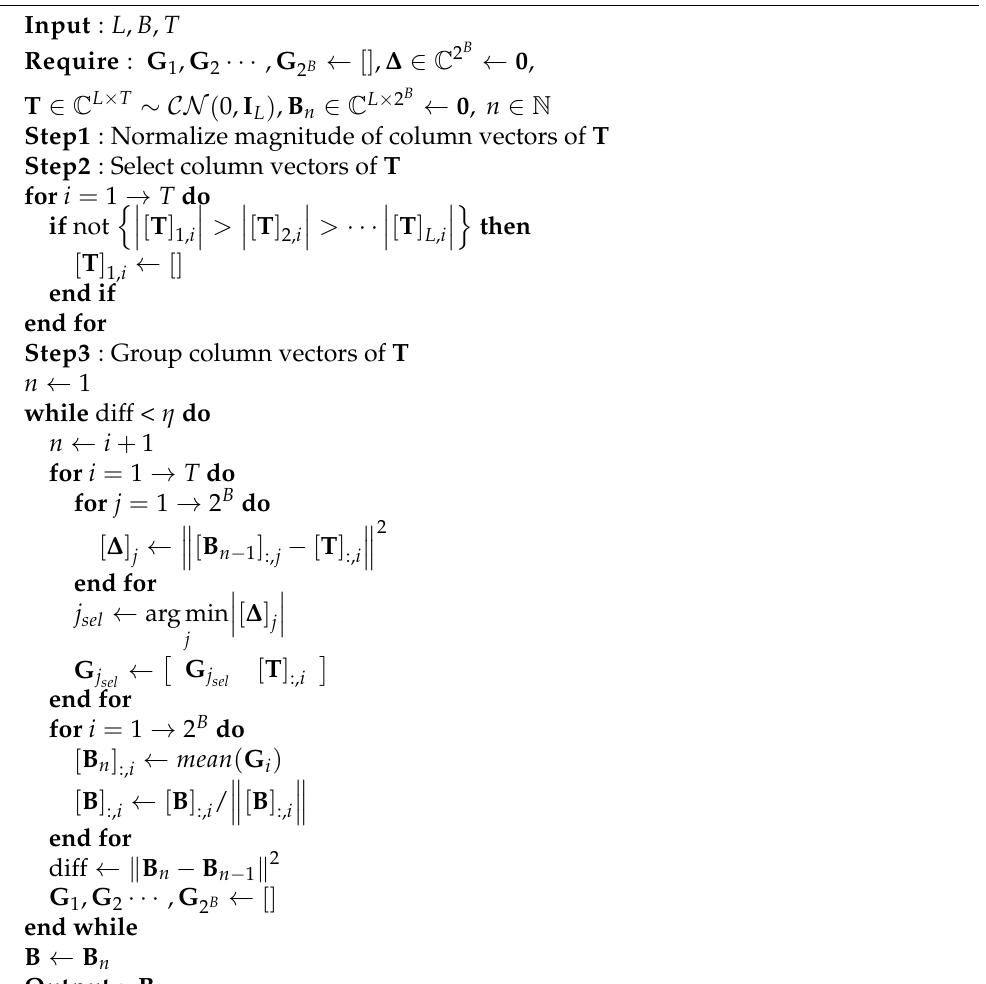
Algorithm 2 Codebook Generation for Conditional